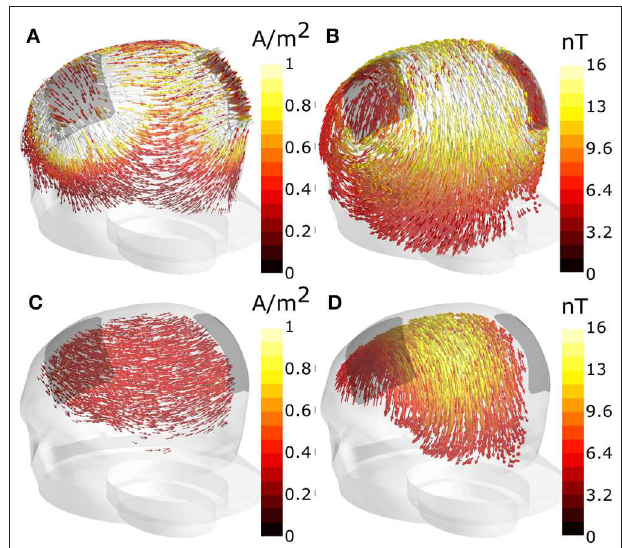
FIGURE 7 | The FEM simulation results for current density J are visualized in the scalp (A) and in the brain compartment (C) . The simulated magnetic field B J , due to all current flowing in the head, is plotted in the scalp (B) and in the brain (D) . The arrow lengths are scaled logarithmically because of the vast magnitude differences especially in the current density. Each subfigure shows only the top 30 (magnitude) percentile of the field in the respective